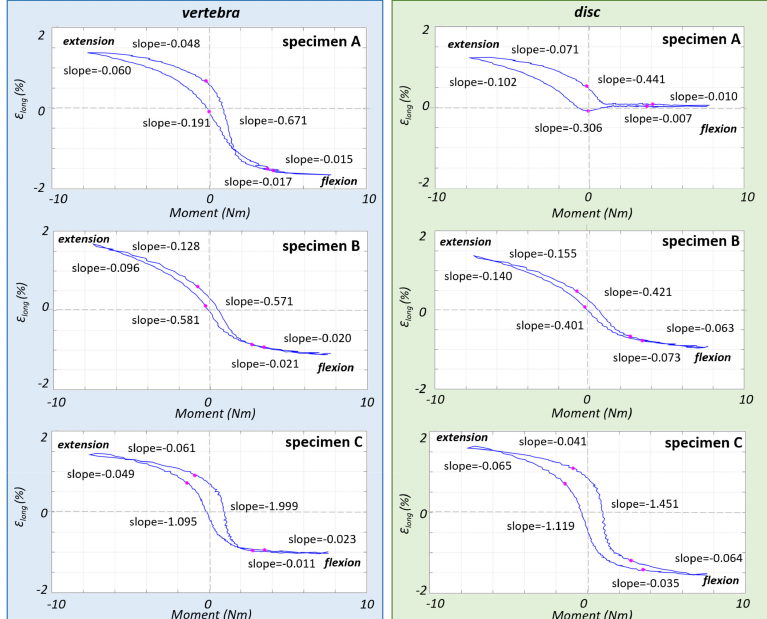
Figure 4. The strain-moment curves of the third loading cycle are reported for each specimen, showing how the strain in the ALL varied in front of the vertebra (left charts) and in front of the disc (right charts) for specimens A, B, C (from top to bottom). The end of the NZ and the beginning of the EZ (identified on moment-angle curves, Figure 2), are reported here with circles. The values of minimum and maximum slope (% strain / Nm) for the NZ and EZ are reported for both of the curve flexion-to-extension and extension-to-flexion.